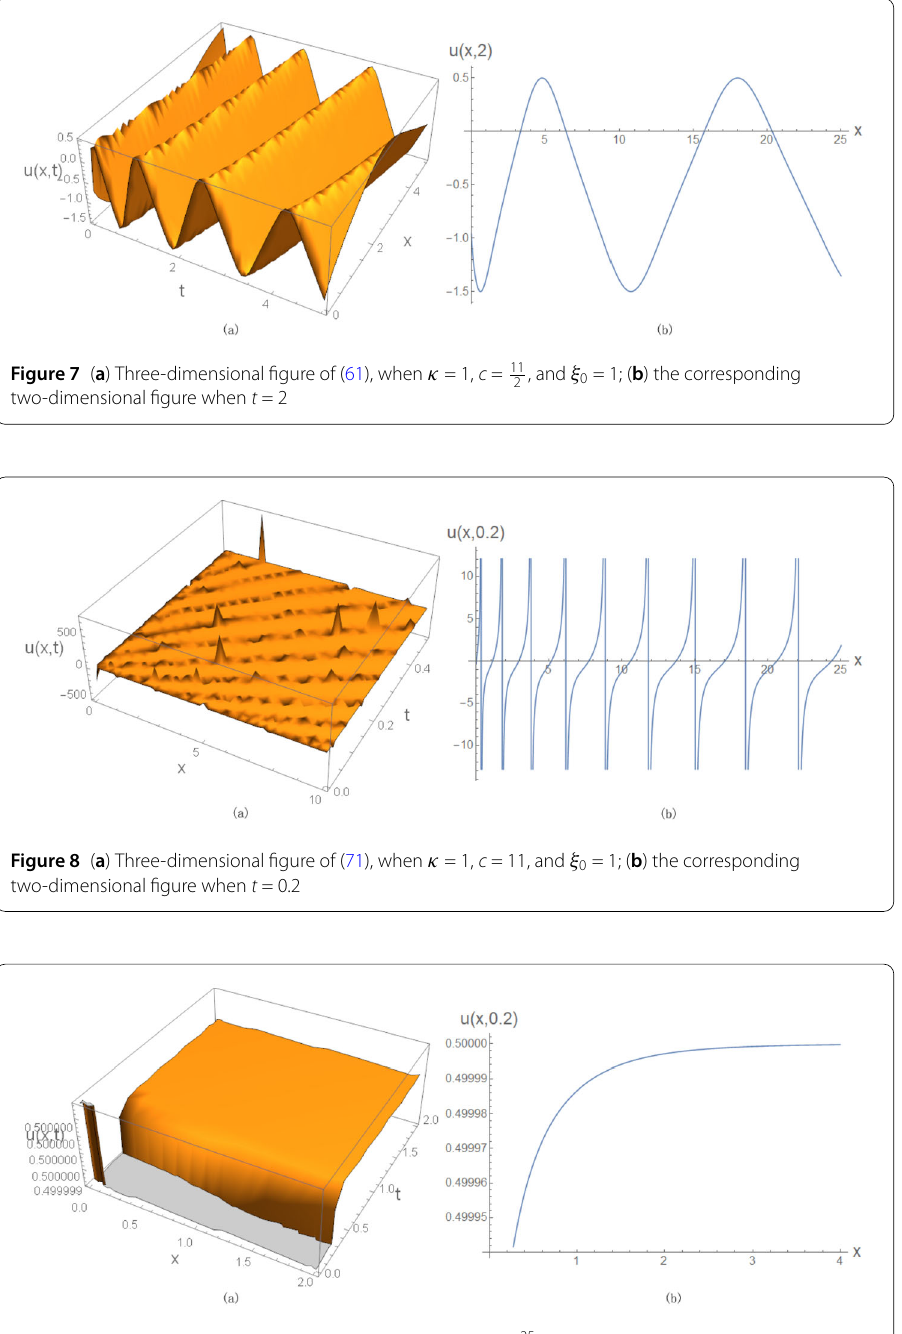
tain Jacobian elliptic functions with periodic solutions by other methods. In this paper, the KdV-mKdV equation is transformed into space-time fractional equation, which is re- duced to usual differential equations by using fractional complex transformation. All pos- sible solutions are given by the complete discrimination system for polynomial method. Similar solutions have not been found in other literature, which also shows the strong